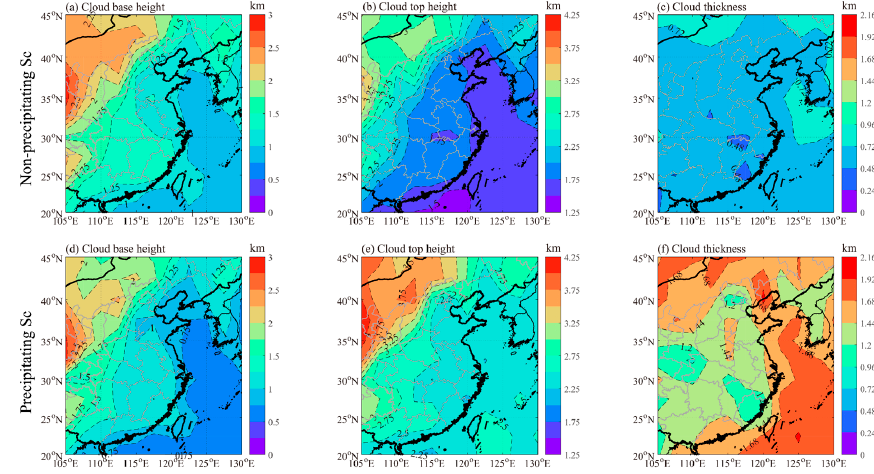
Figure 3. Spatial distributions of average cloud base heights ( a , d ), top heights ( b , e ) and cloud thicknesses ( c , f ) of NPS ( a – c ) and PS ( d – f ) clouds over